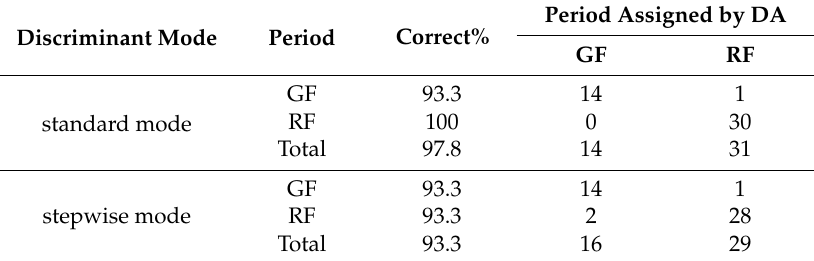
Table 4. Verification and classification functions for DA of temporal variations.